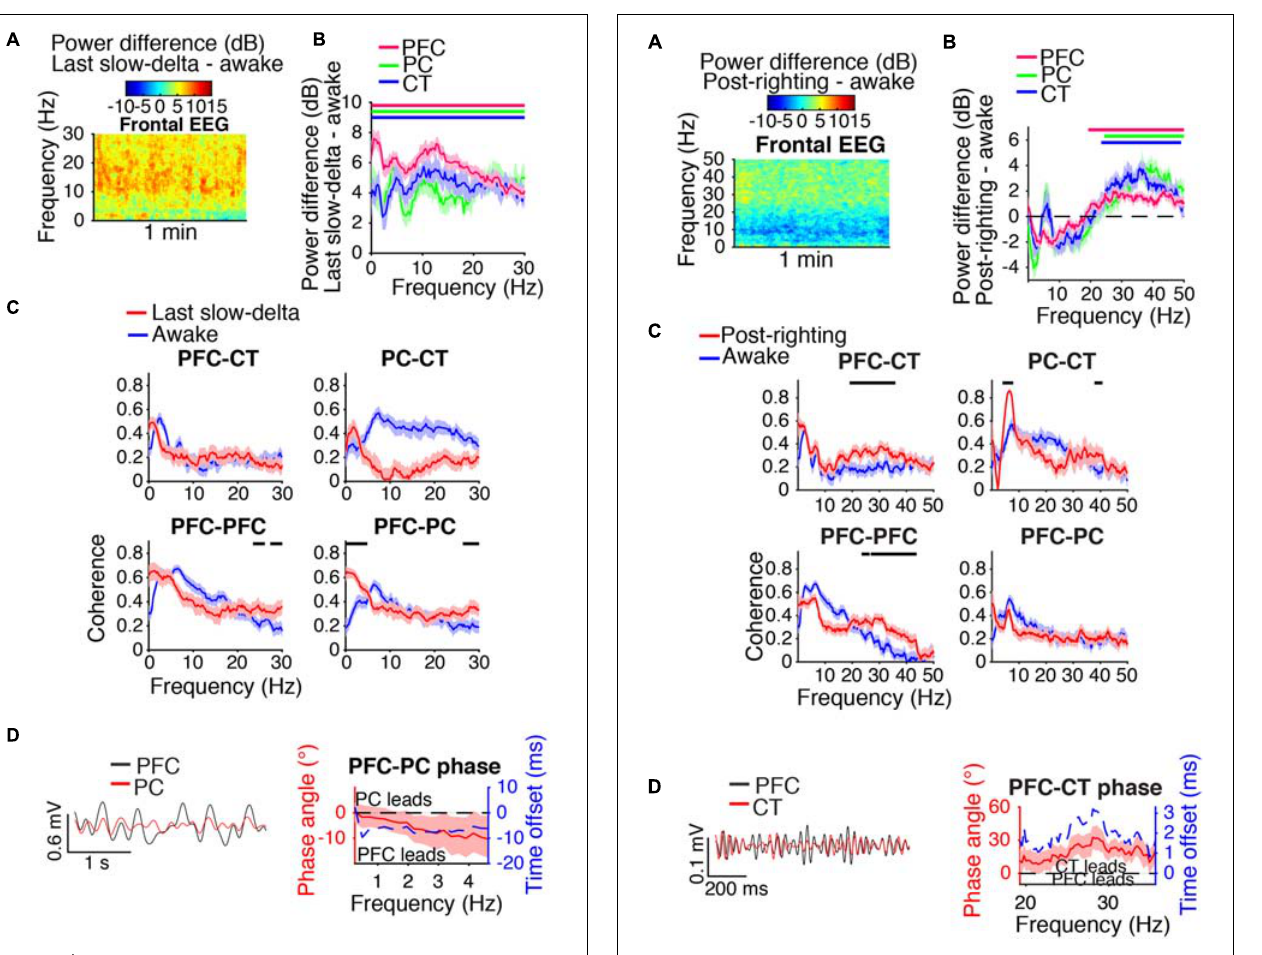
FIGURE 8 | Dynamics following ROR. (A) Group difference spectrogram of the frontal EEG during the first artifact-free minute following righting. The same period is analyzed in (B–D) . (B) Group power difference for PFC (red), PC (green), and CT (blue) LFPs. Shading indicates 95% confidence intervals. Red, green, and blue horizontal lines mark ranges of significant power increase relative to awake baseline for PFC, PC, and CT LFPs, respectively. (C) Group coherence between LFPs during awake baseline (blue) and post-righting (red) states. Shading indicates 95% confidence intervals, and horizontal lines mark ranges of significant coherence increase from awake baseline. (D) Left: PFC (black) and CT (red) LFPs from a representative animal filtered in the range of significant PFC–CT LFP coherence increase shown in (C) . Right: Group PFC–CT LFP phase relationship shown for the range of significant PFC–CT LFP coherence increase shown in (C) , in terms of phase angle (left y -axis, red line) and time offset (right y -axis, blue dotted line). Shading indicates 95% confidence intervals for phase angle. A positive phase relationship indicates that the first signal lags the